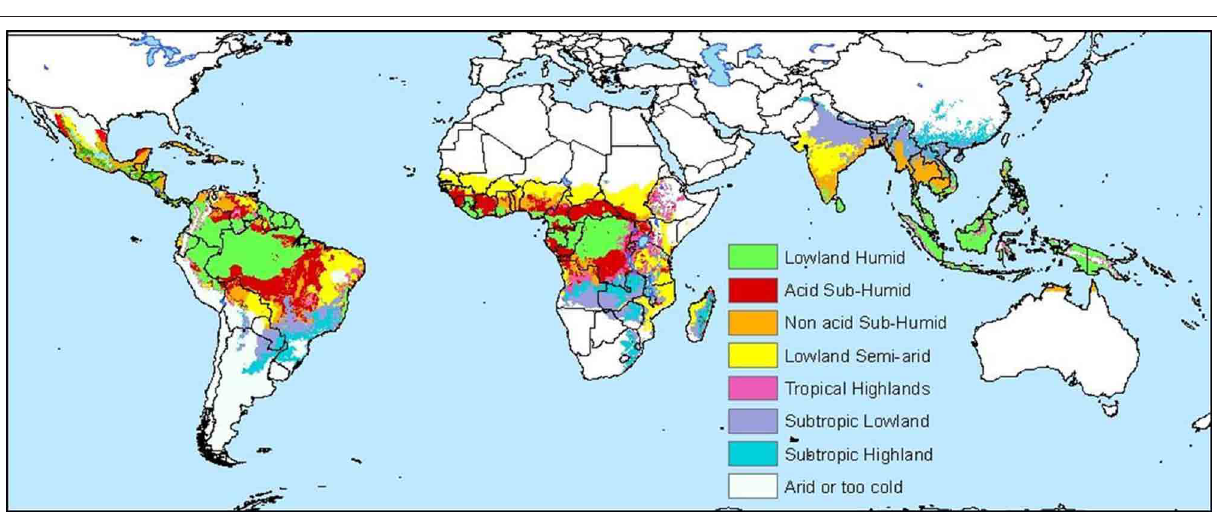
FIGURE 4 | Edapho-climatic map of cassava (CIAT,